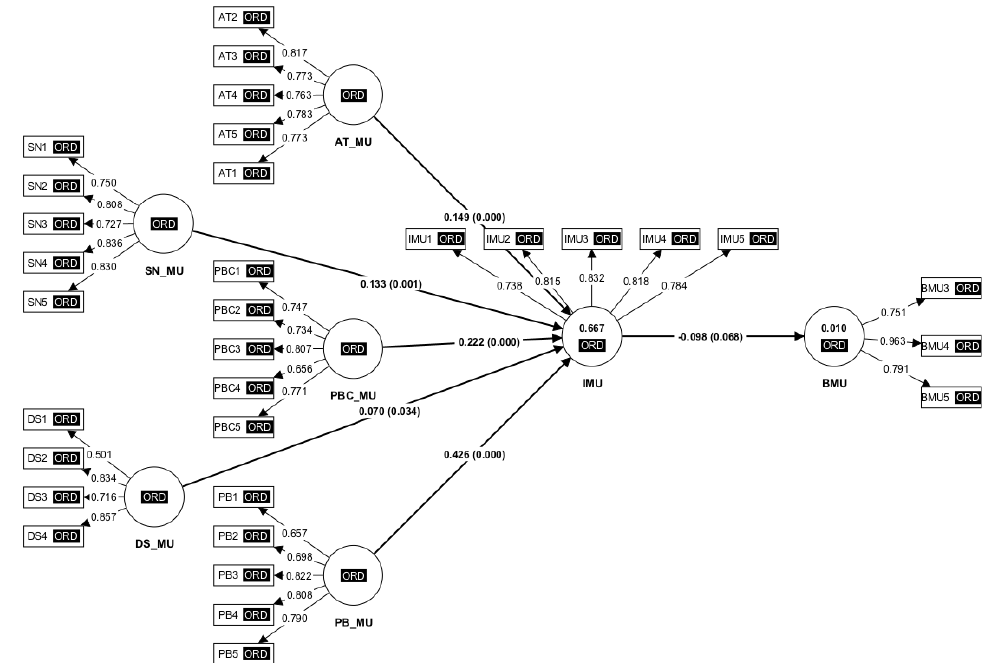
Figure 2. Outer model with factor loading value and R square. Table 4. Fornell–Larcker criterion.